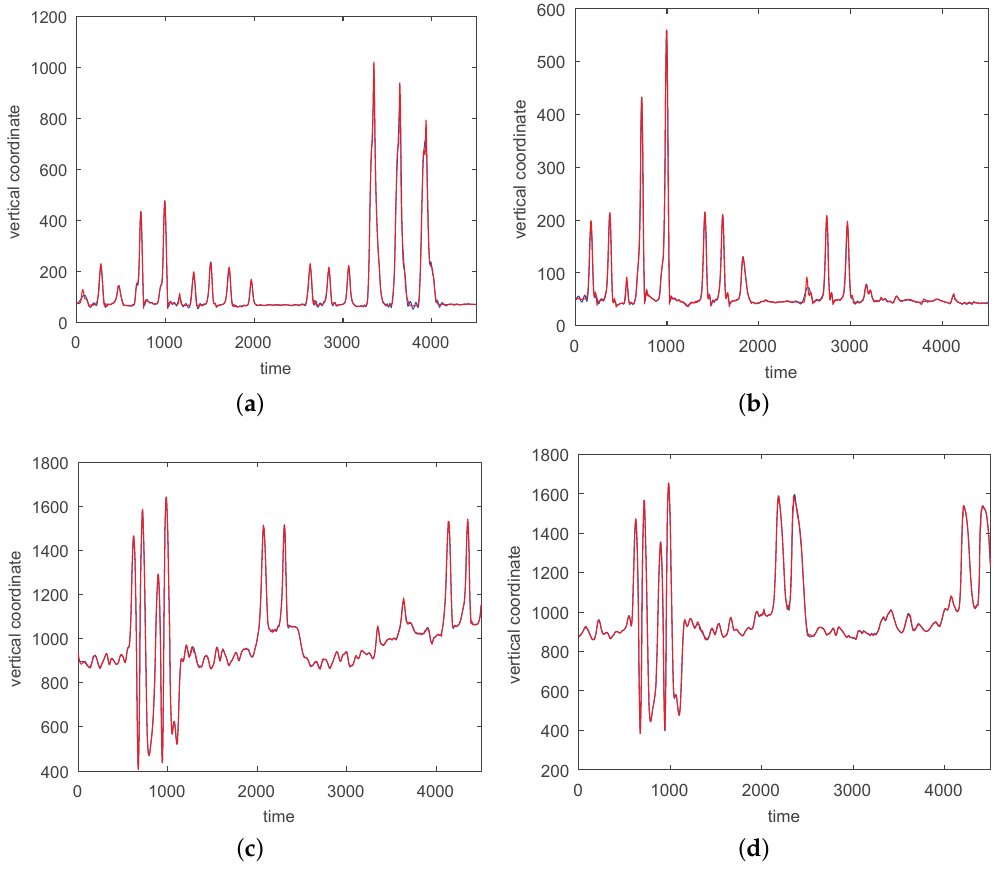
Figure 8. An approximation of z (vertical) coordinates by 200 neurons and two centers for a simple non-segmented motion (sampled at 120Hz). The center frequencies are 0.30 Hz and 0.72 Hz. ( a ) z -coordinate for the right heel; ( b ) The left heel; ( c ) z -coordinate for the right wrist, distal; ( d ) The left wrist, distal. The red curves show the experimentally observed coordinates and the blue curves give their neural